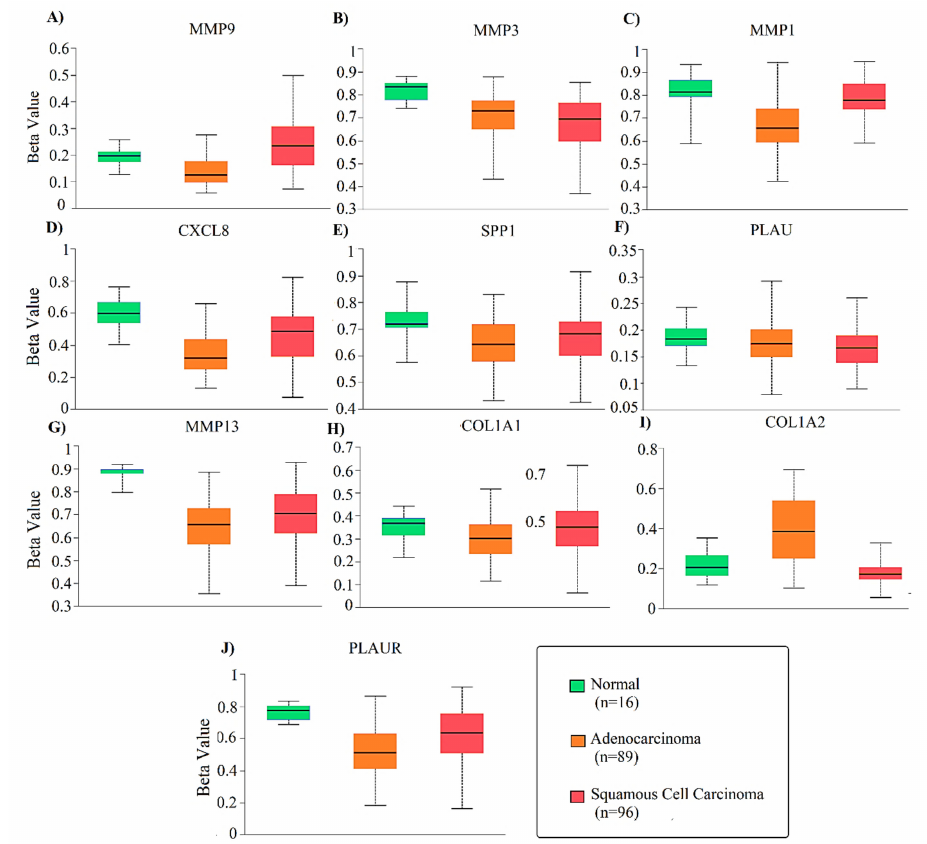
Figure 6. The promoter methylation for the HGsT10 genes was identified with the TCGA ESCA samples based on the disease type ( A – J ). UALCAN server was used to determine if hyper-methylation [beta value: 0.7–0.5] or hypo-methylation [beta value: 0.3–0.25] were prevalent. A statistically significant comparison was made between normal and non-normal